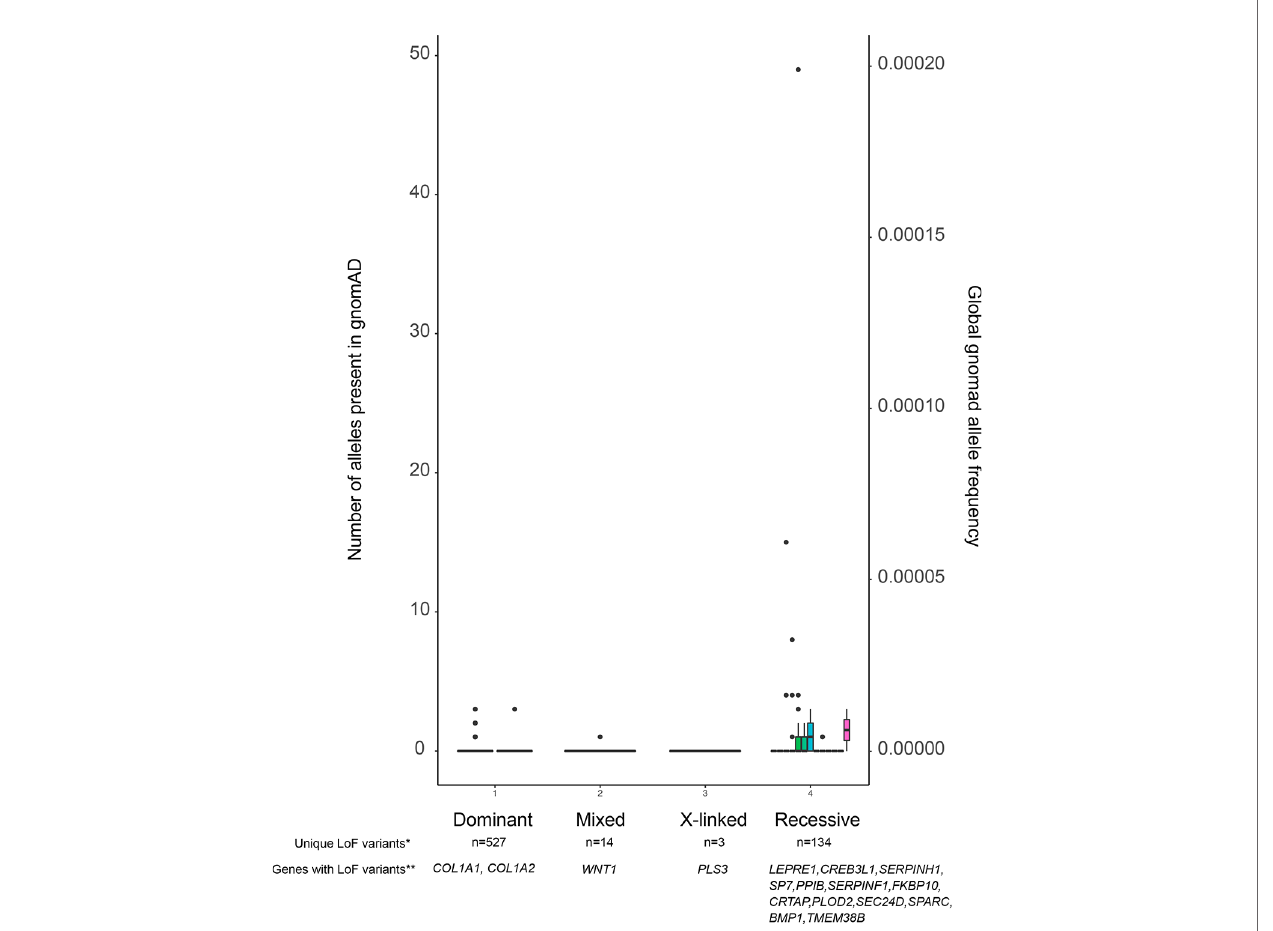
FIGURE 2 | Allele frequencies of LoF variants in the OI database. The fi gure displays all variants, and their allele frequencies, reported to the OI database which is contained within the Leiden Open Variation Database (LOVD). Because the LOVD also contains benign variants, we have chosen to use LoF variants as a proxy for all pathogenic variants. As is shown, pathogenic variants are not only very rare in dominant OI genes, but they are also very rarely found in recessive OI genes. *Number of unique LoF variants in OI genes reported in the LOVD. **Genes with reported LoF variants in LOVD. Note that not all known OI genes have LoF variants, as annotated by VEP (35), reported in